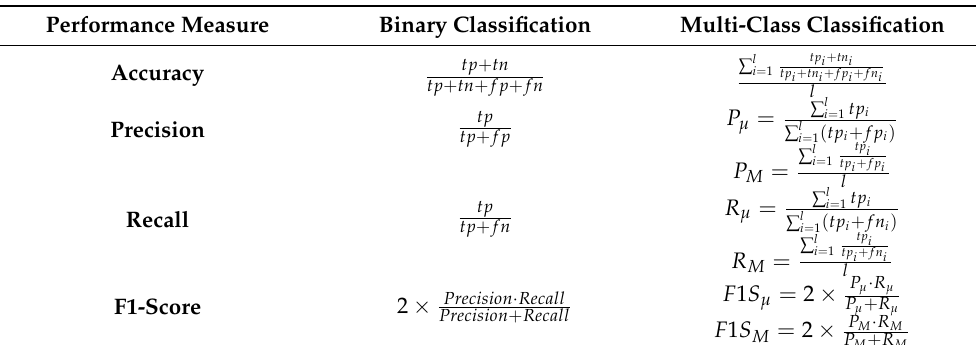
Table 3. Performance Metrics.